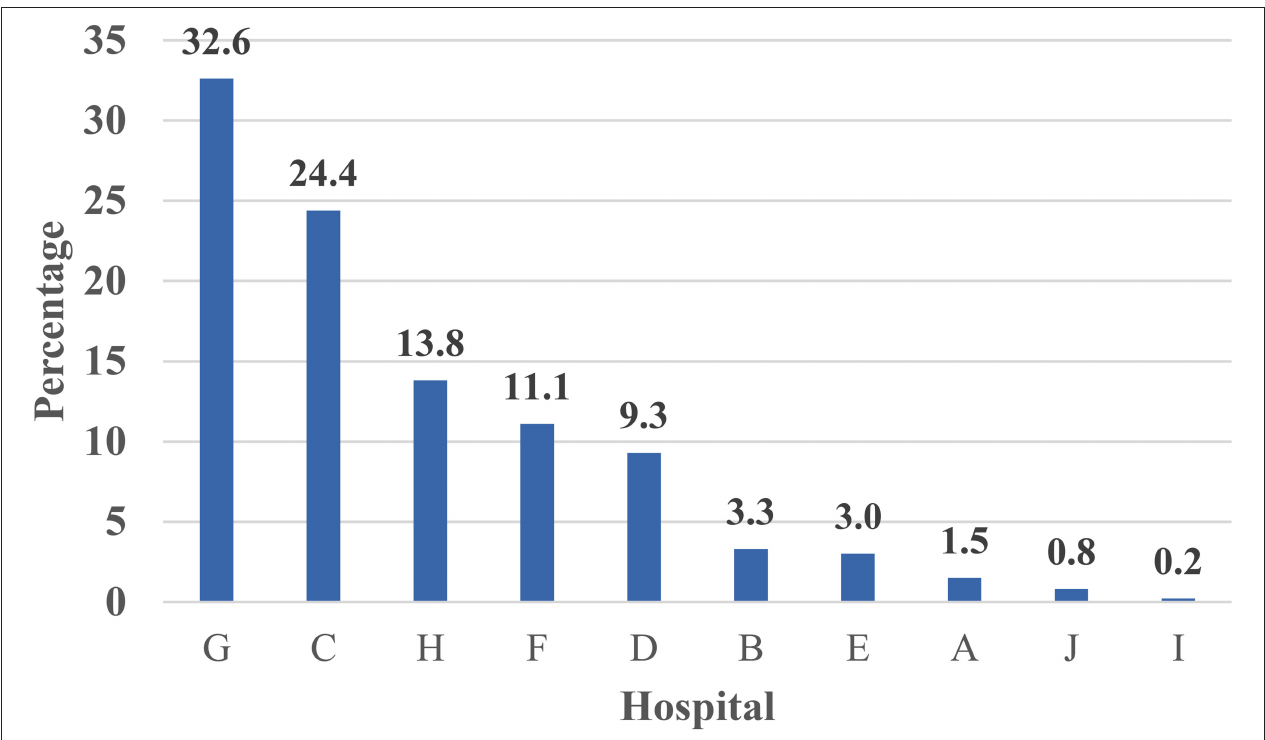
FIGURE 5 | Percent distribution of PCR confirmed COVID-19 across 10 Teaching hospitals among medical personnel—Egypt: (June 1 to July 15, 2020)—Rank ordering.